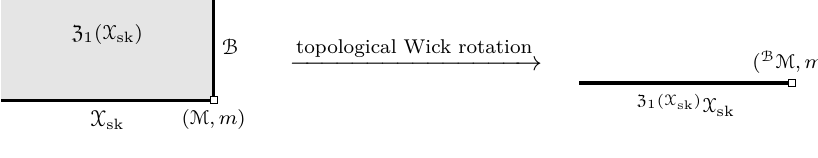
Figure 3 . The topological skeleton of the boundary of a SPT/SET